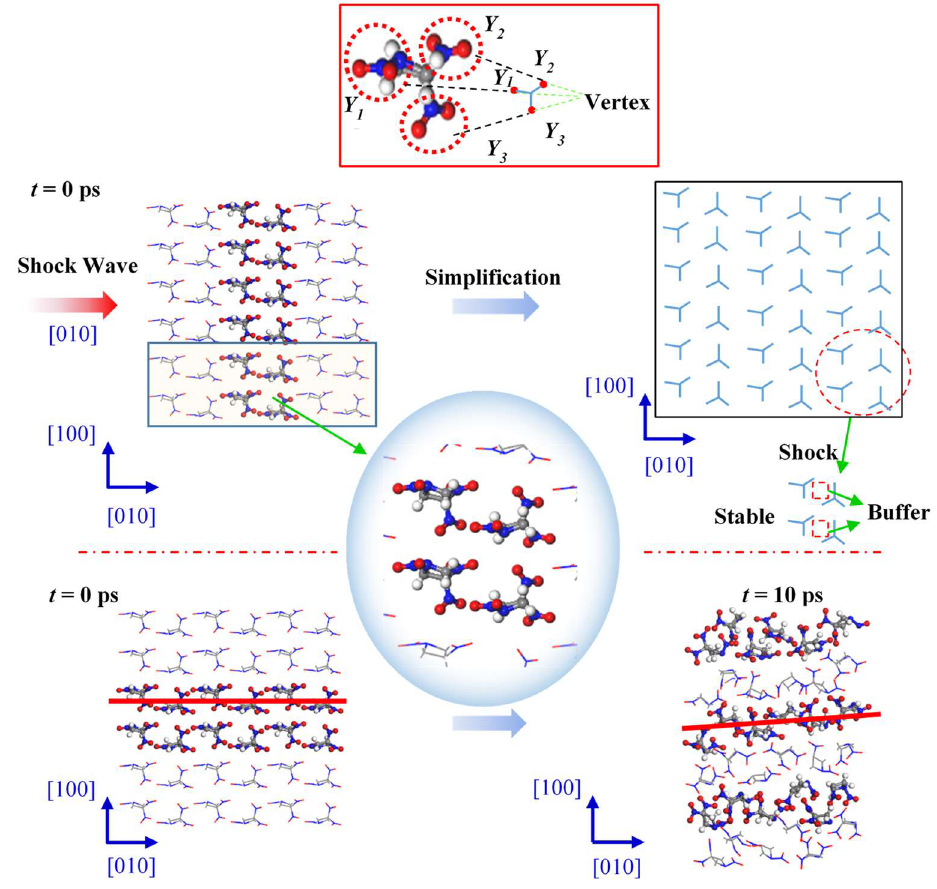
Figure 6. Molecular arrangement of TNAZ in the [010]